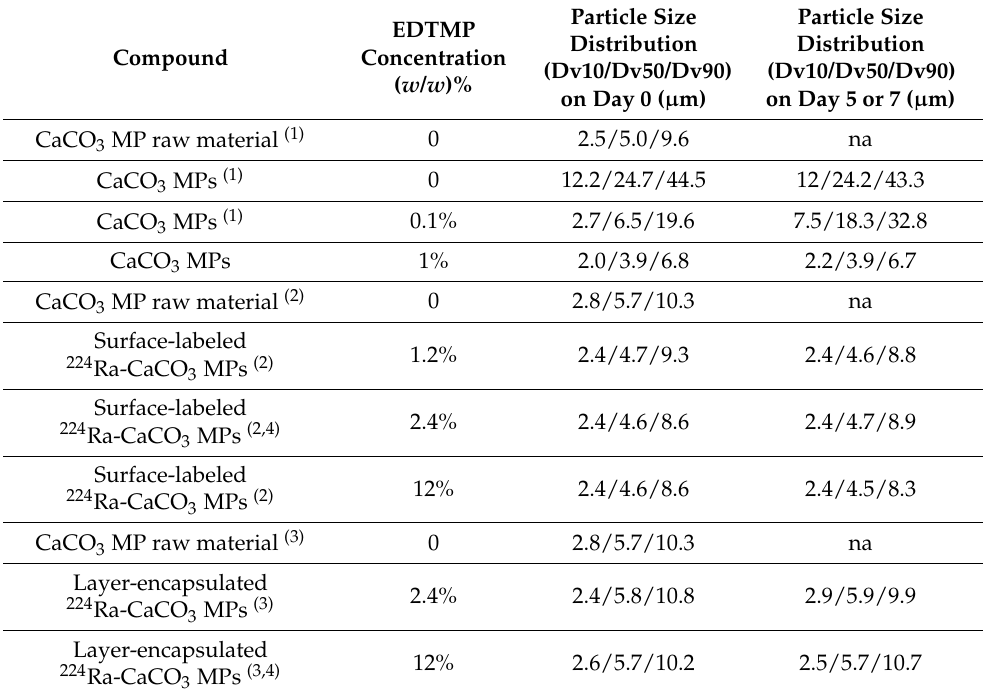
Table 1. Size distribution of various CaCO 3 MPs from Figure 2, shown as the volumetric 10th percentile (Dv10), 50th percentile (Dv50), and 90th percentile (Dv90). Day 0 refers to the day of preparing the sample including autoclaving of all samples with the exception of the raw material. na: not applicable. Particle Size Particle Size EDTMP Distribution Distribution Compound Concentration (Dv10/Dv50/Dv90) (Dv10/Dv50/Dv90) ( w / w )% on Day 5 or 7 ( µ m) on Day 0 ( µ m) CaCO 3 MP raw material (1) 0